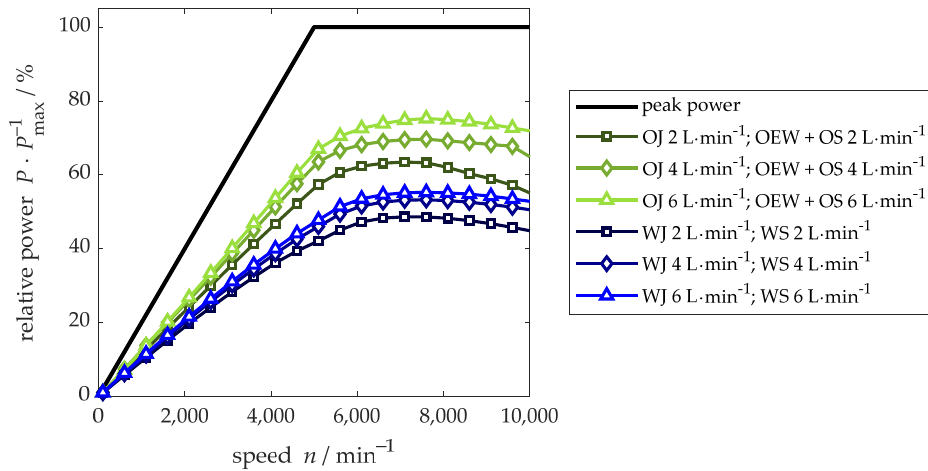
Figure 8. Comparison of the continuous power as a function of machine speed for water and oil cooling at different volume flow rates in the rotor shaft (WS/OS), the stator jacket (WJ/OJ) and the end winding cooling (OEW).